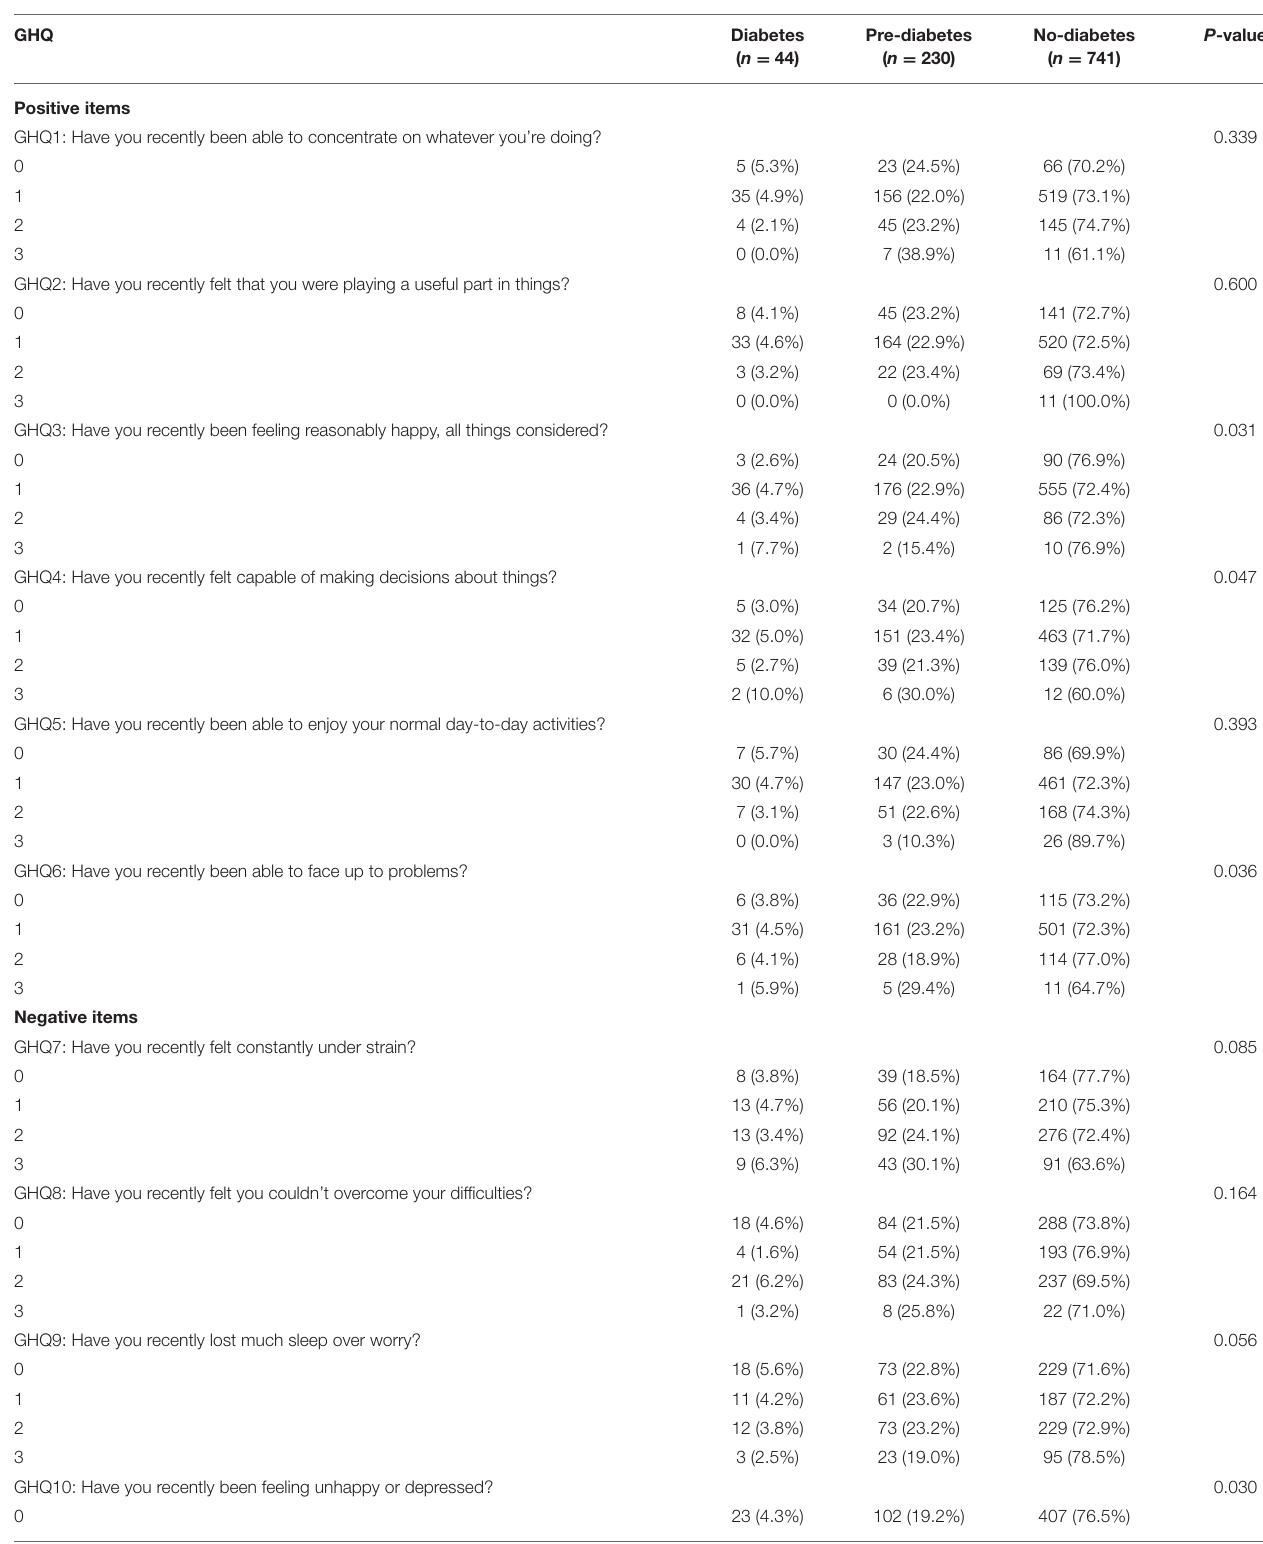
TABLE 1 | Comparison among diabetic, prediabetic, and non-diabetic subjects according to positive and negative general health questionnaire (GHQ)-12 items in the Al Kharj study ( n = 1,016). GHQ Diabetes